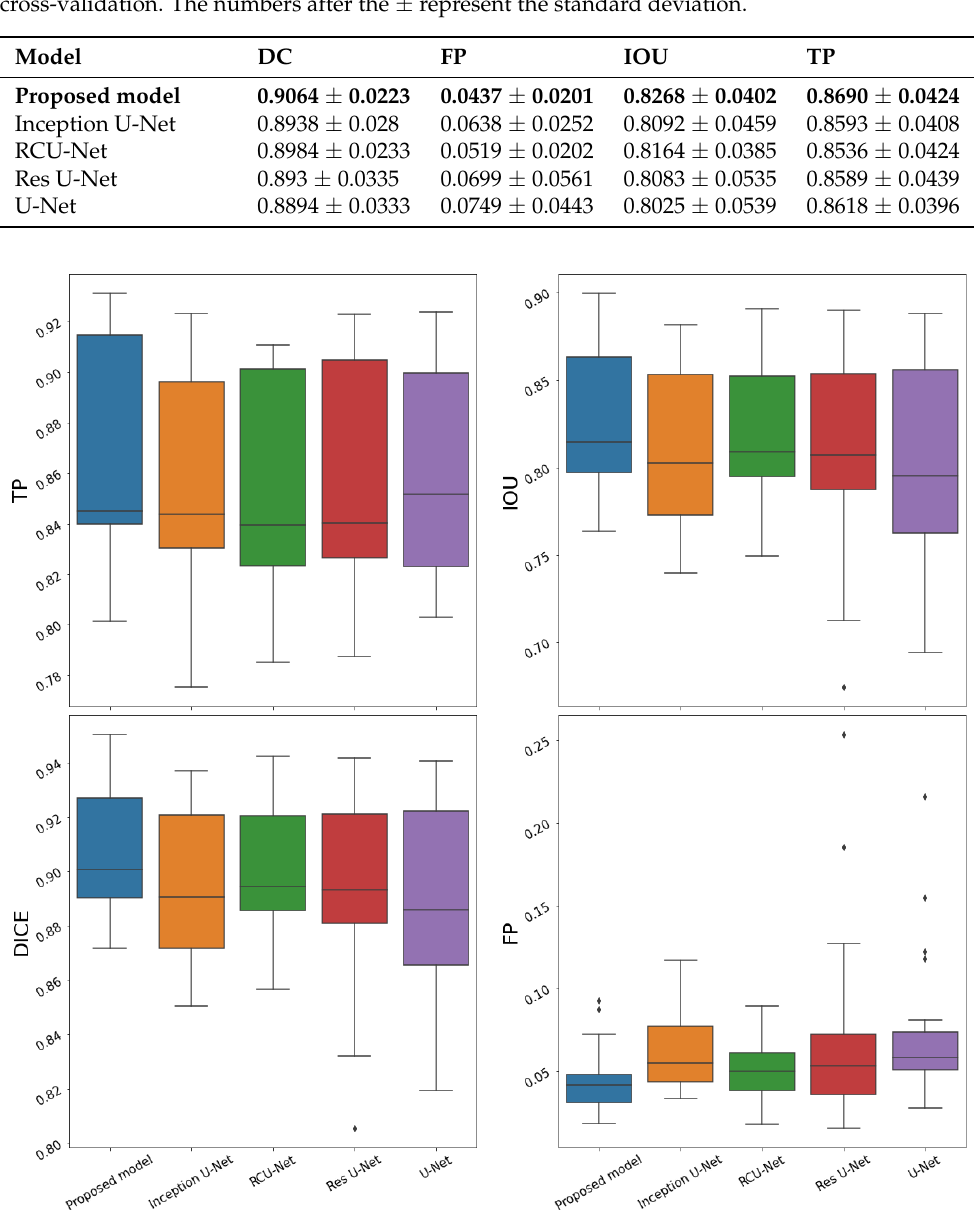
Figure 4. Performance of the five models in the four metrics. TP, IOU, DC, and FP averaged across the four outputs using 5-fold cross-validation. The x -axis represents the model name and the y -axis the values of the metric. It can be seen that the proposed model has a better average performance in all metrics except the